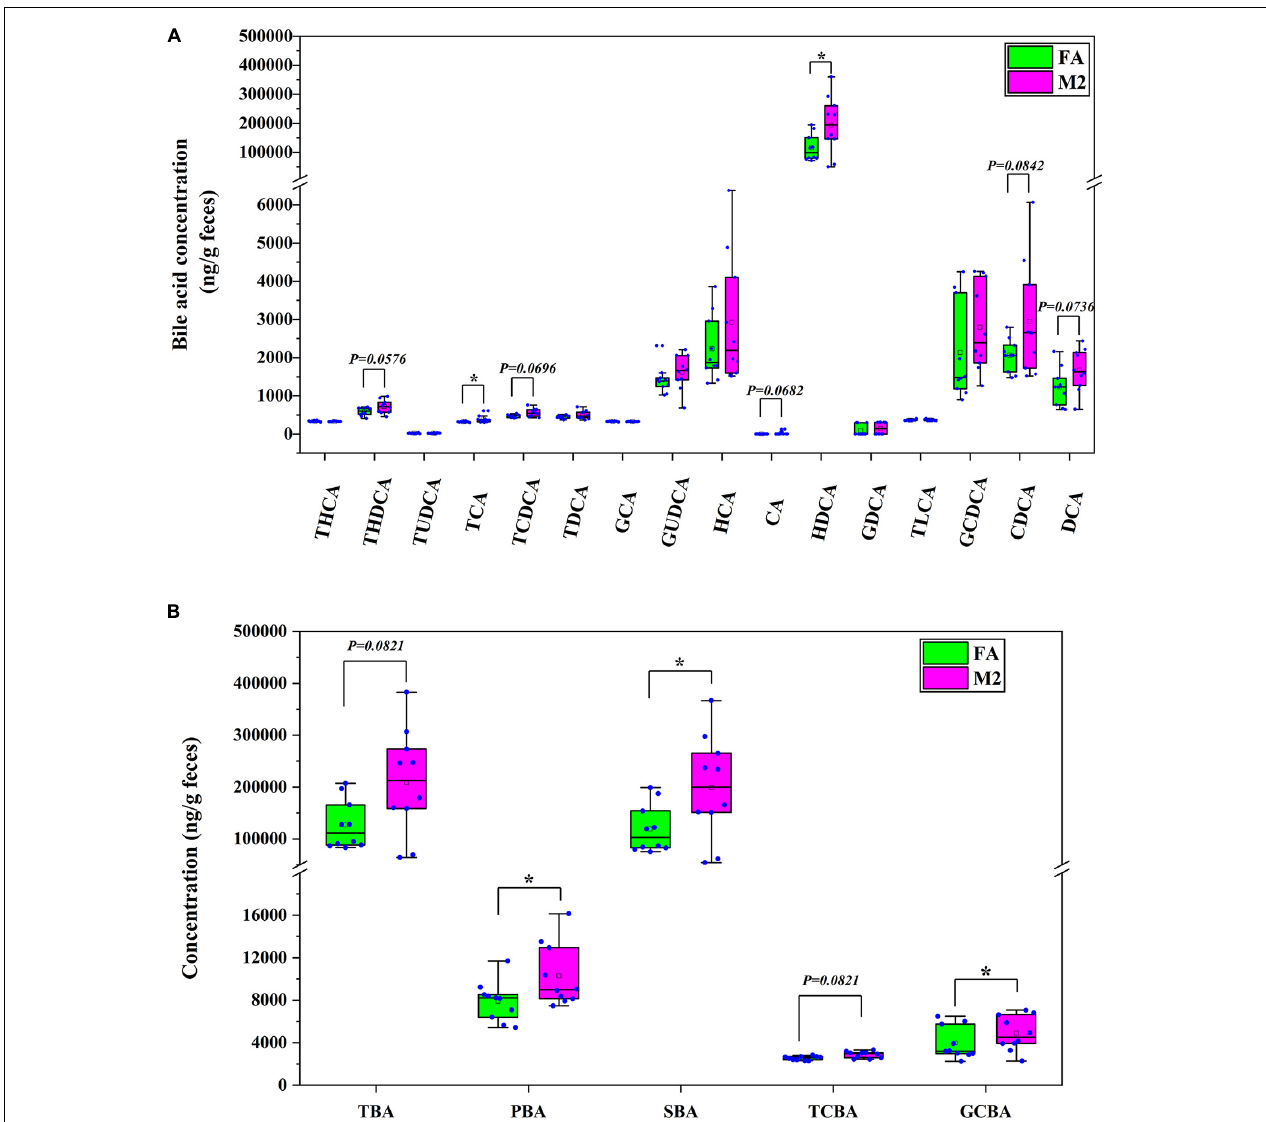
FIGURE 5 | Bile acid profile in feces of pigs. (A) The concentration of each bile acid in feces. (B) The concentration of each type of bile acid in feces. FA, pigs had free access to feed; M2, pigs were given two meals per day (0800 and 1800 h); each meal lasted 60 min. * p < 0.05. THCA, tauro-hyocholic acid; THDCA, tauro-hyodeoxycholic acid; TUDCA, tauro-ursodeoxycholic acid; TCA, tauro-cholic acid; TCDCA, tauro-chenodeoxycholic acid; TDCA, tauro-deoxycholic acid; GCA, glycol-cholic acid; GUDCA, glycol-ursodeoxycholic acid; HCA, hyocholic acid; CA, cholic acid; HDCA, hyodeoxycholic acid; GDCA, glycol-deoxycholic acid; TLCA, tauro-lithocholic acid; GCDCA, glycol-chenodeoxycholic acid; CDCA, chenodeoxycholic acid; DCA, deoxycholic acid; TBA, total bile acid; PBA, primary bile acid; SBA, secondary bile acid; TCBA, taurine-conjugated bile acid; GCBA, glycine-conjugated bile acid.